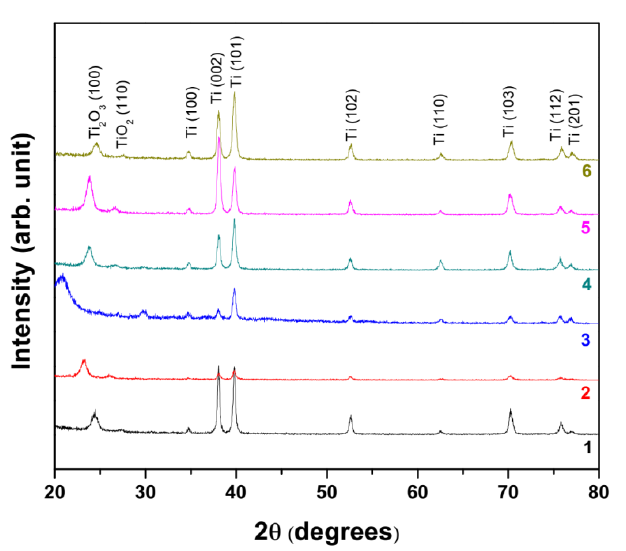
Fig.3. XRD profiles of the different retrieved